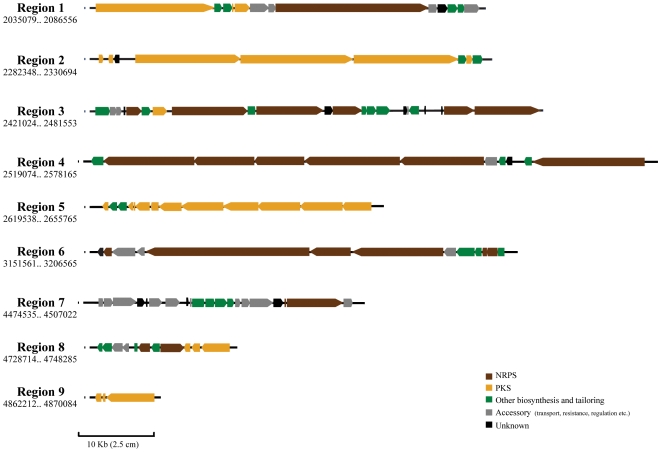
Secondary metabolism gene clusters of T. turnerae.Predicted secondary metabolite gene clusters in the genome of T. turnerae T7901. Regions are shown in order of distance from the origin of replication. Sequence coordinates of each region are indicated beneath the region number. NRPS: nonribosomal peptide synthetase, PKS, polyketide synthase.